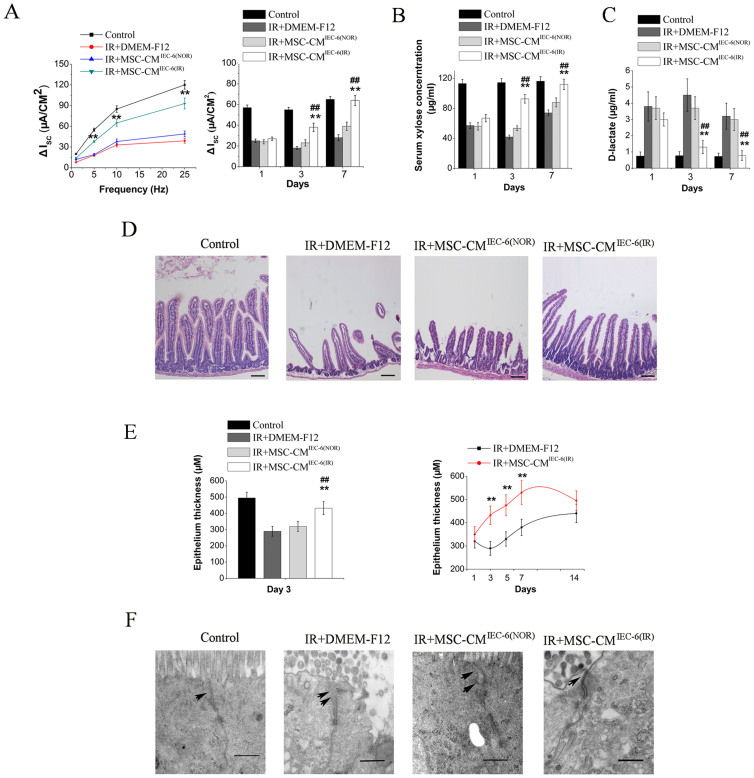
MSC-CMIEC-6(IR) restores intestinal functionality and structure of irradiated rats.(A) Changes of intestinal electrolyte transport were measured by short-circuit current analysis (Isc) in response to electrical filed stimulation (EFS). (left panel) Isc response was stimulated by increasing frequencies of EFS ranging from 1 ~ 25 Hz. (right panel) Isc response was studied 1, 3, 7 days after irradiation. Data are expressed as the change in Isc and are the mean ± SD for n = 6 animals. **, P < 0.05 versus IR + DMEM-F12, ##, P < 0.05 versus IR + MSC-CMIEC-6(NOR). (B) D-Xylose absorption tests were performed at 1, 3, 7 days after irradiation. Values represent means ± SD of n = 3 animals, **, P < 0.05 versus IR + DMEM-F12, ##, P < 0.05 versus IR + MSC-CMIEC-6(NOR). (C) Intestinal permeability, measured as plasma level of D-lactate, was measured at 1, 3, 7 days after irradiation. Values represent means ± SD of n = 3 animals, **, P < 0.05 versus IR + DMEM-F12, ##, P < 0.05 versus IR + MSC-CMIEC-6(NOR). (D) Histological analysis by H&E staining. Scale bars 100 μm. (E) Morphometric evaluation of epithelium thickness. Each value represents the average of 20 independent measurements per animal (six animals per group). **, P < 0.05 versus IR + DMEM-F12, ##, P < 0.05 versus IR + MSC-CMIEC-6(NOR). (F) The morphological changes of intestinal tight junction after radiation. The structures between the adjoining cells were observed under transmission electron microscopy. Arrows, tight junctions; bars, 500 nm. IR + DMEM-F12, irradiated rats receiving DMEM-F12; IR + FB-CMIEC-6(IR), irradiated rats receiving FB-CMIEC-6(IR); IR + MSC-CMIEC-6(NOR), irradiated rats receiving MSC-CMIEC-6(NOR); IR + MSC-CMIEC-6(IR), irradiated rats receiving MSC-CMIEC-6(IR).